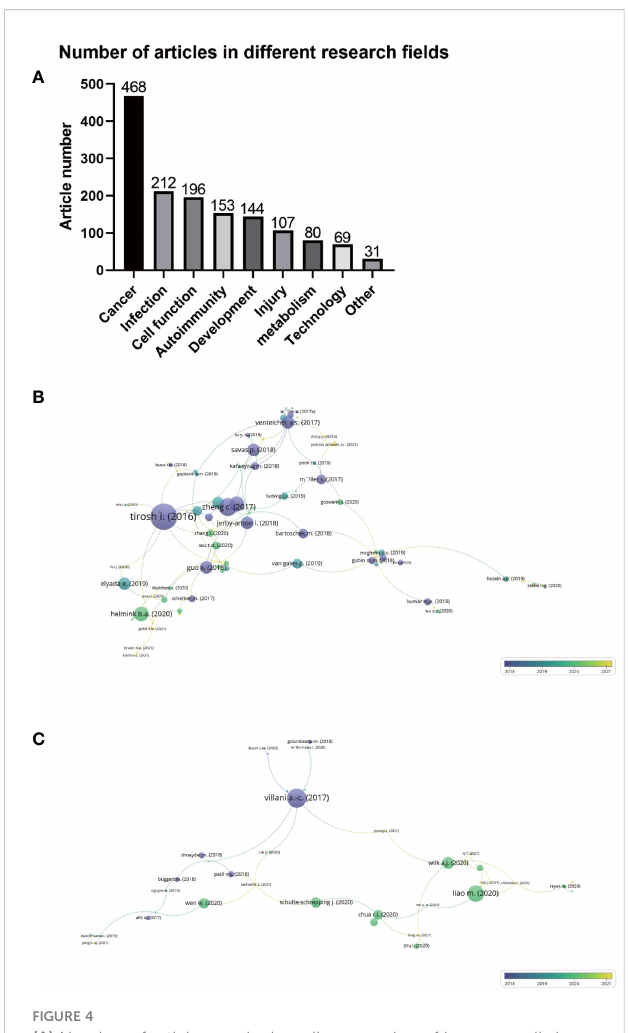
FIGURE 4 (A) Number of articles on single-cell sequencing of immune cells in different research fi elds. (B) Citation-documents analysis of articles using single-cell sequencing to detect immune cells in the fi eld of oncology. (C) Citation-documents analysis of articles using single-cell sequencing to detect immune cells inthe fi eld of infections. Circle size represents the number of citations, and lines represent the link strength of the documents with